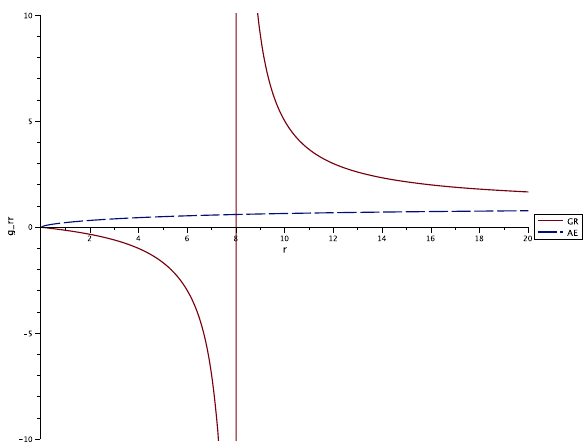
Fig. 1 Plot of the metric component g rr , for EA parameters c 14 = 16 / 9, α = − 1 and an arbitrary Schwarzschild mass M = 4. The continuousredlinerepresentstheGRSchwarzschildmetric.Thedashed blue line represents the EA solution. Calculating the limit r → +∞ we obtain g rr = e 2 B → 1, as we can see in this figure. Calculating the limit r → r sing 1 = 0 we obtain g rr = e 2 B → 0, as we can see in this figure